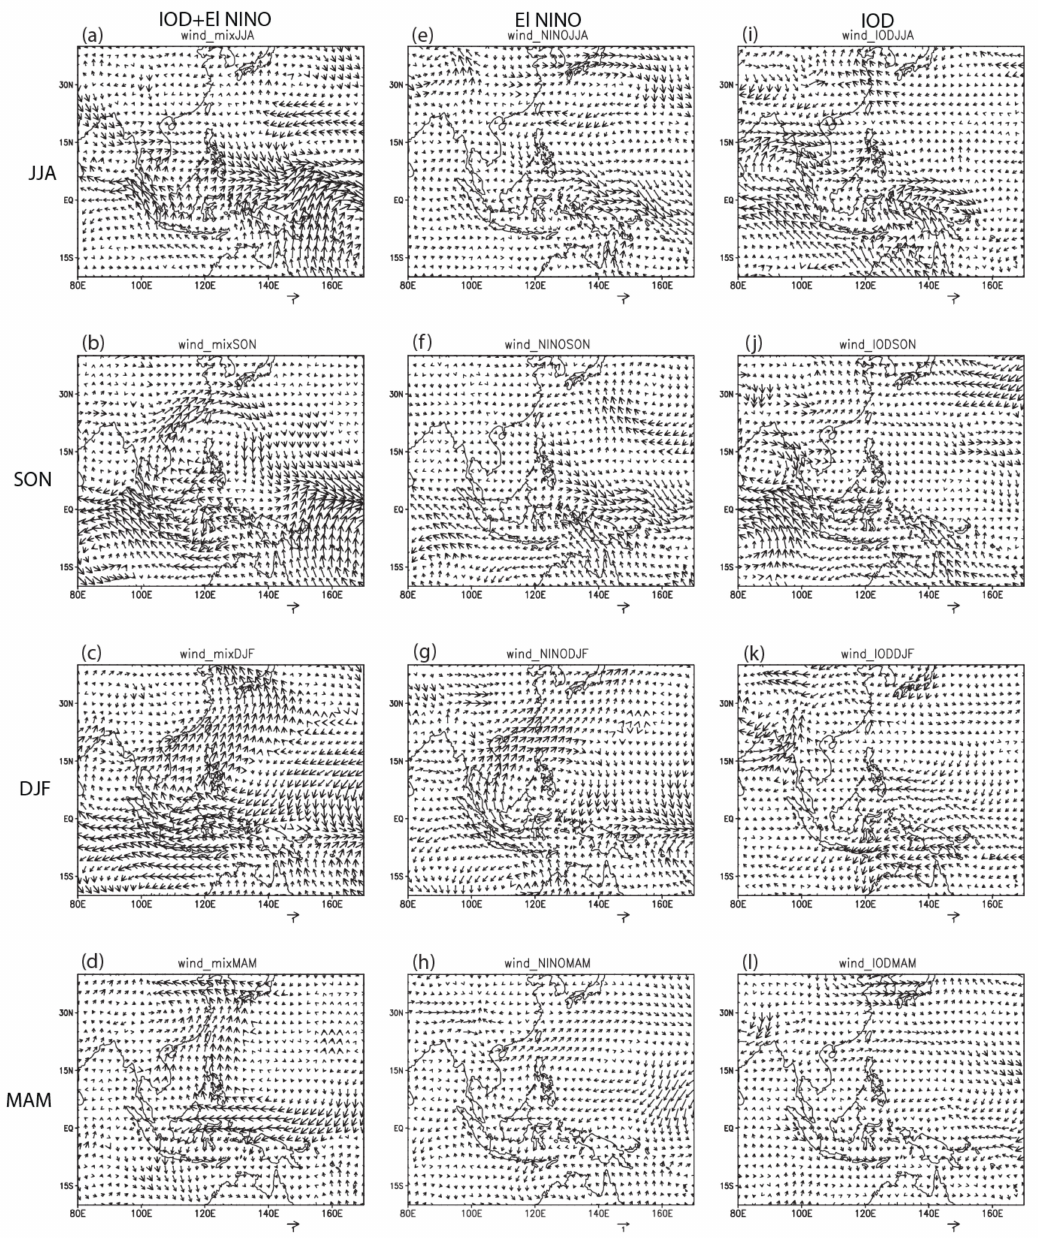
Figure 5. The composite of anomalous low-level wind at 850 mb for the events listed in Table 1. The bolded vector with a larger arrowhead indicates significance at the 95% level. ( a – d ) Co-occurrence of the conventional El Niño and positive IOD, ( e – h ) pure conventional El Niño, and ( i – l ) pure positive IOD for the seasons of JJA, SON, DJF, and MAM. Unit is ms − 1